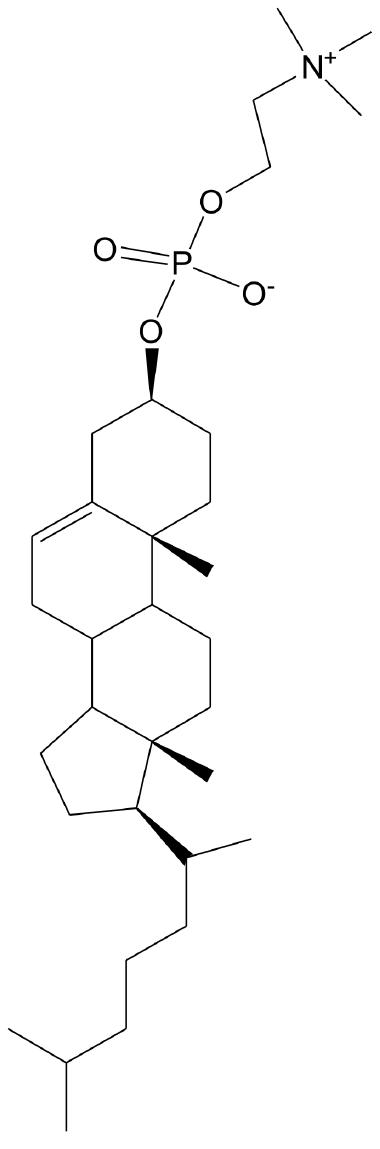
Figure 1. Chemical structure of CholPC.